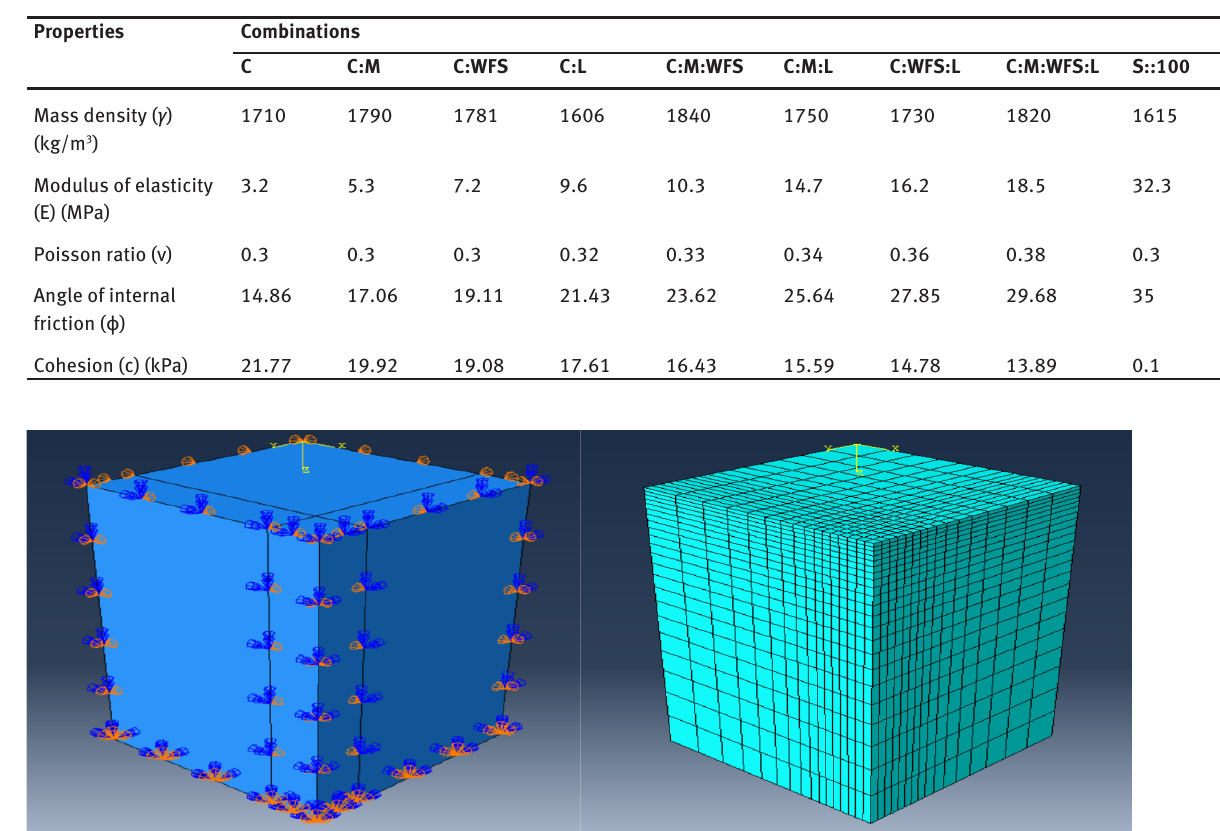
Table 8: Material properties of unstabilized/stabilized clayey soil and sandy soil (Mohr–Coulomb model) [23].